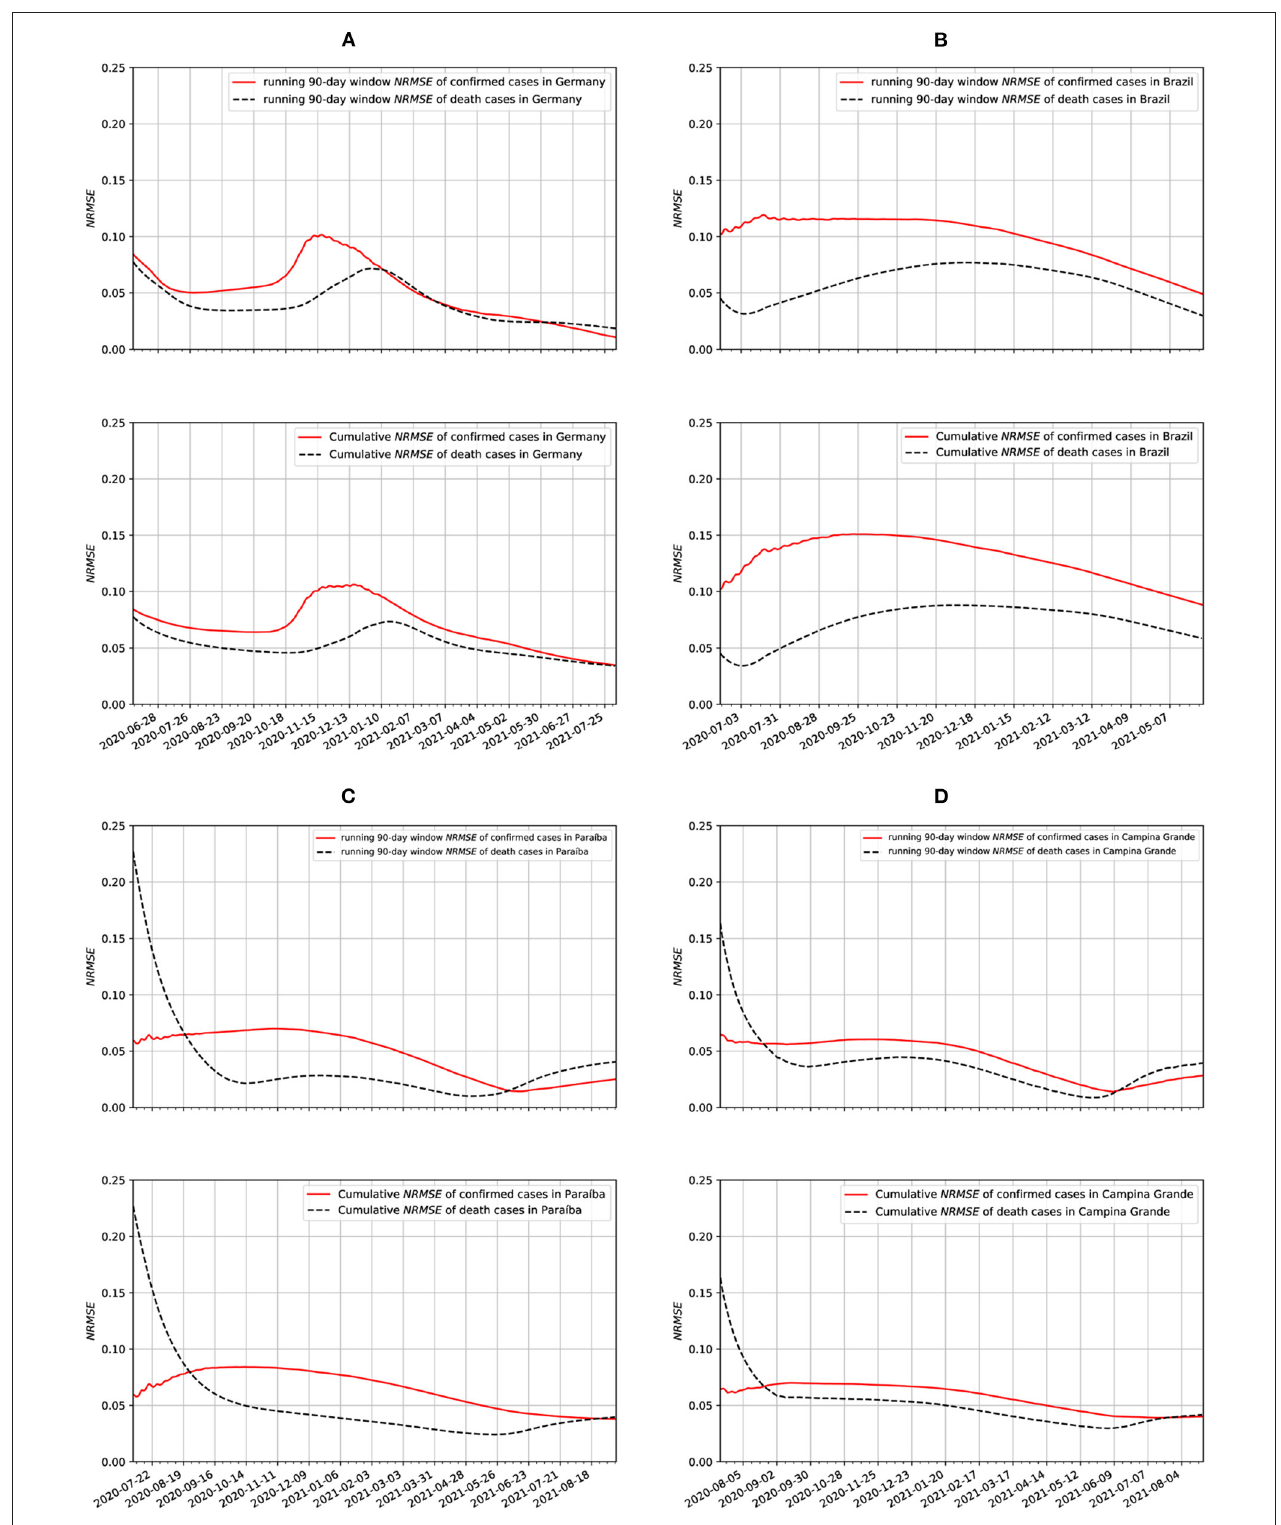
FIGURE 11 | Running window and cumulative NRMSE data for: (A) Germany, (B) Brazil, (C) Paraíba, and (D) Campina Grande.